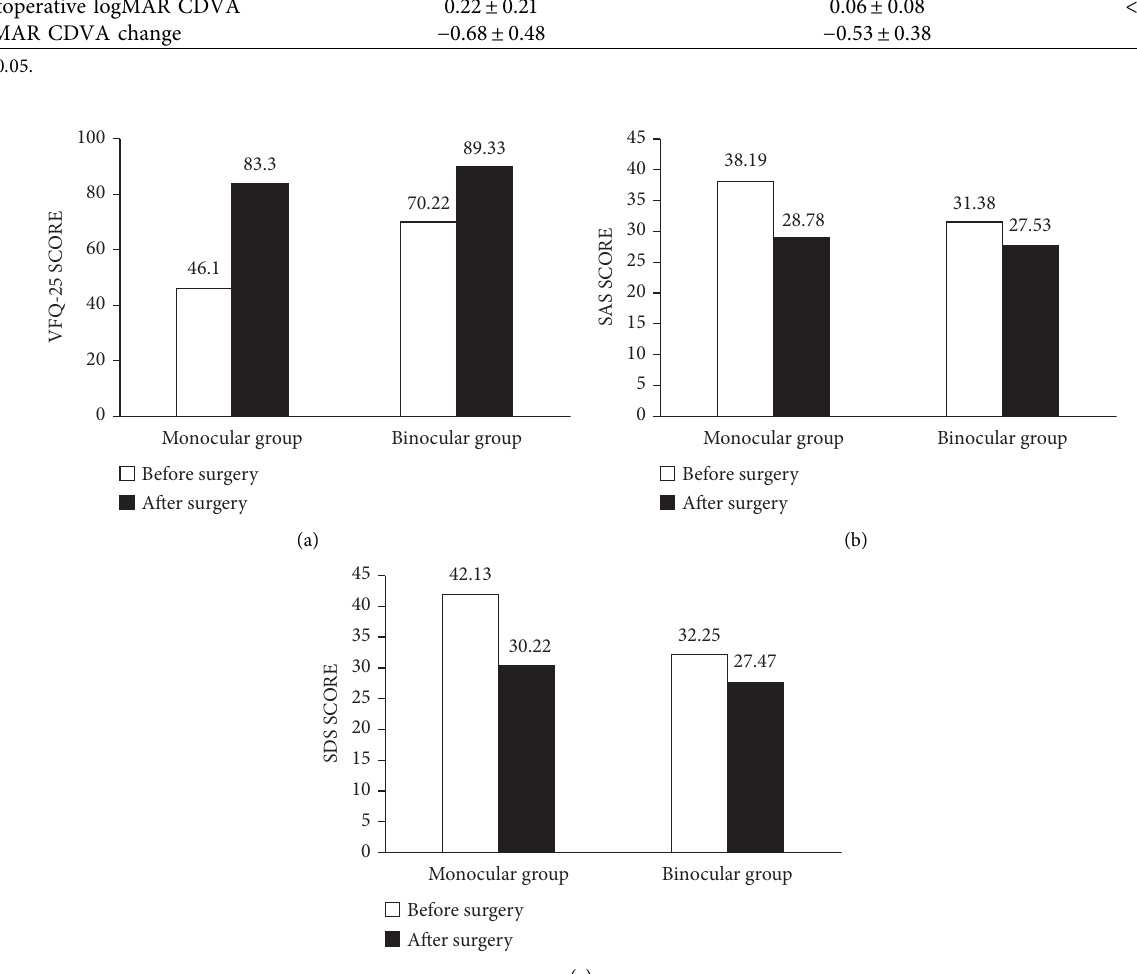
Figure 1: (a) Composite scores of the NEI-VFQ-25 for the monocular and binocular groups before and after surgery. (b) Comparison of the scores of self-rating anxiety scale between two groups before and after surgery. (c) Comparison of the scores of self-rating depression scale between two groups before and after surgery.